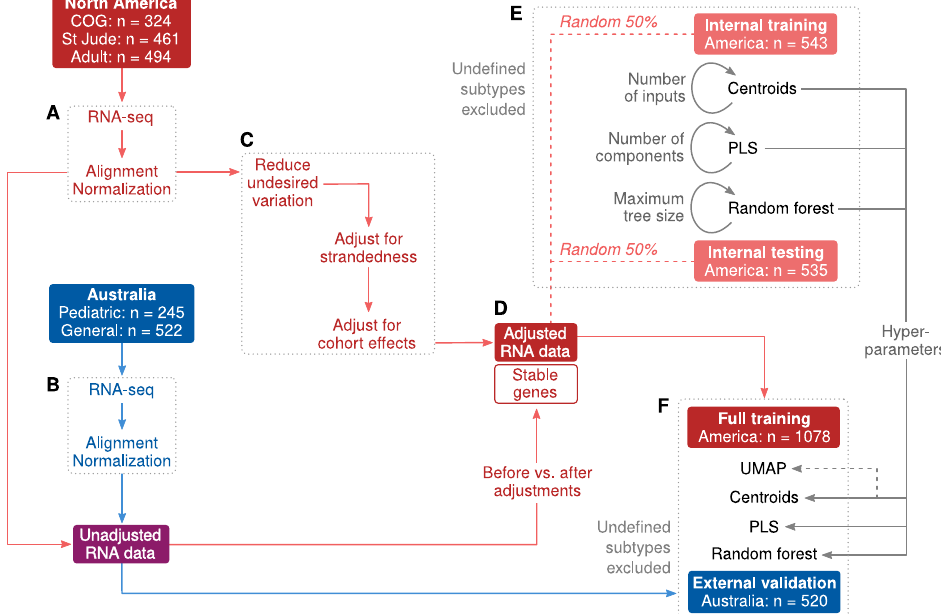
Figure 1. Study design. ( A , B ) RNA-seq pre-processing was applied separately for North American and Australian datasets. ( C ) Non-biological differences due to technical artifacts and cohort effects were adjusted according to genetically matched subsets (details in Methods). ( D ) Correlation coef- ficients were calculated between unadjusted and adjusted expression levels to exclude genes that were heavily influenced by confounders. A total of 6673 stable genes with R ≥ 0.9 were included for subtype modeling. ( E ) Internal training and testing sets were randomly chosen from the North American participants as initial material to evaluate machine learning models and to determine hyperparameters. The randomization was conducted separately for each subtype to ensure matching subtype frequencies, which explains the small difference in set sizes. ( F ) Final machine learning models were trained with the full North American dataset and validated in the Australian dataset.